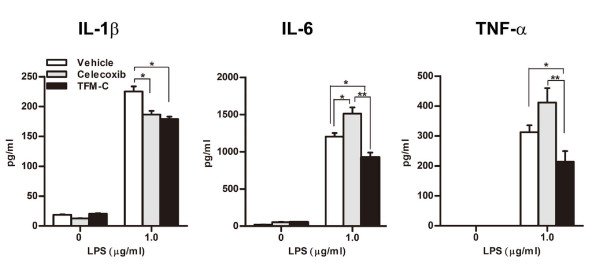
TFM-C supresses the activation of macrophages. B6 mice recieved 10 μg/g TFM-C, celecoxib or vehicle on Day 0 and Day 2, and on Day 3, splenic macrophages were collected and were stimulated by LPS in vitro in the presence of TFM-C, celecoxib or vehicle. Cytokines were detected by ELISA. IL-1β and IL-6 were measured 24 h after stimulation. TNF-α was measured six hours after stimulation. The data shown are from a single experiment representative of three similar experiments. * P < 0.05 compared with control group, * P < 0.05 compared with celecoxib-treated group.